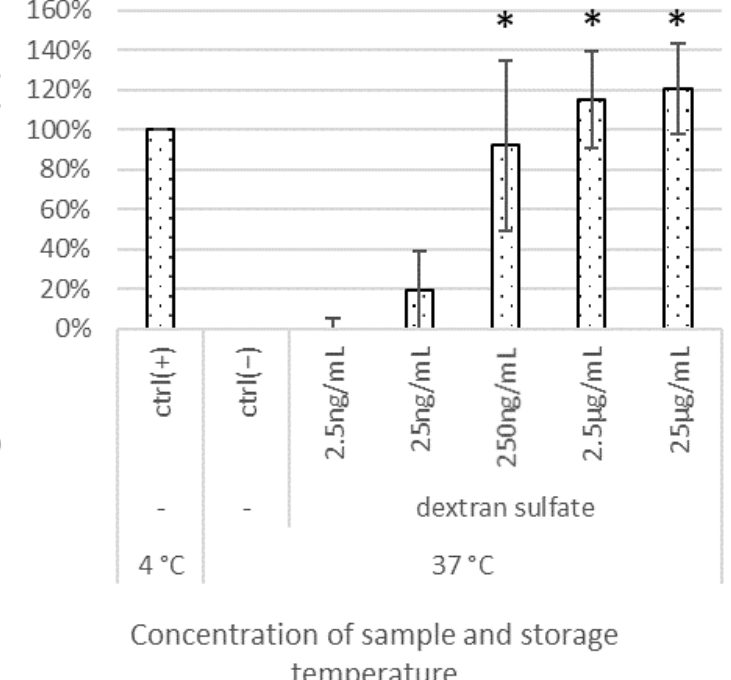
Figure 1. Effects of dextran sulfate on bFGF concentrations in iPSC culture media. bFGF concentra- tions were measured using an ELISA. The differences between the detected amounts of bFGF in test culture and negative control were considered significant at * p < 0.05. Microsoft Excel for Microsoft Apps for Enterprise was used for preparation of the